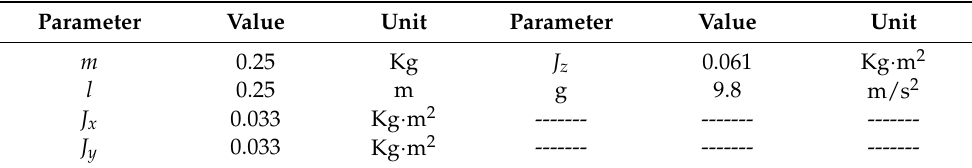
Table 1. Some physical parameters for the